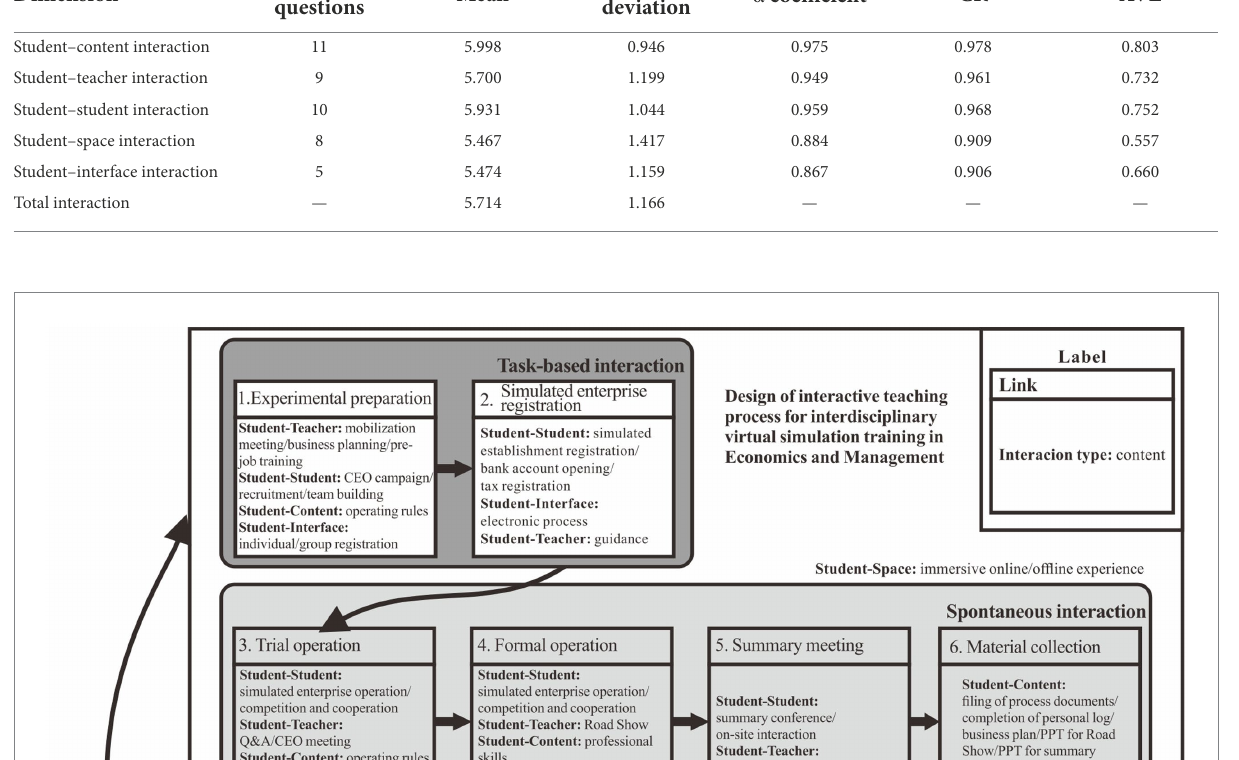
TABLE 2 Descriptive statistics, reliability, and validity tests of scale dimensions.